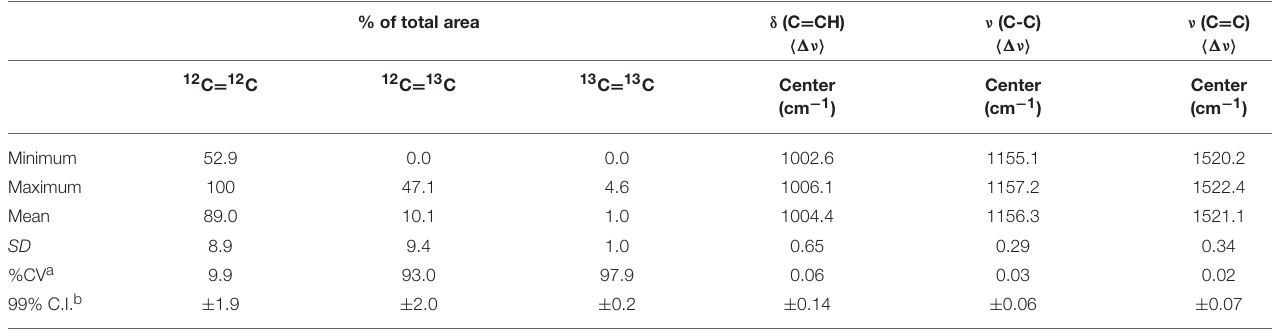
TABLE 1 | Analytical precision of single-cell resonance Raman spectral features assessed from 150 Synechococcus sp. (RS9916) continuously cells grown at natural 13 C abundances ( f media = 0.011).